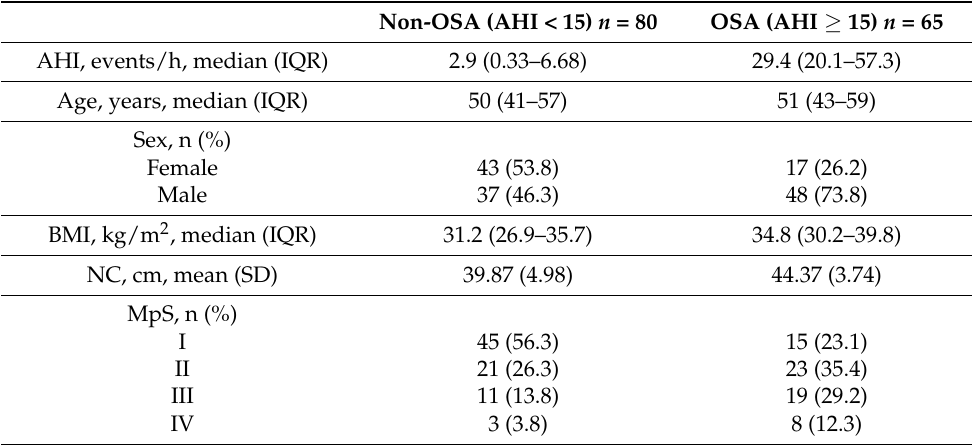
Table 2. Anthropometric information characteristics of the